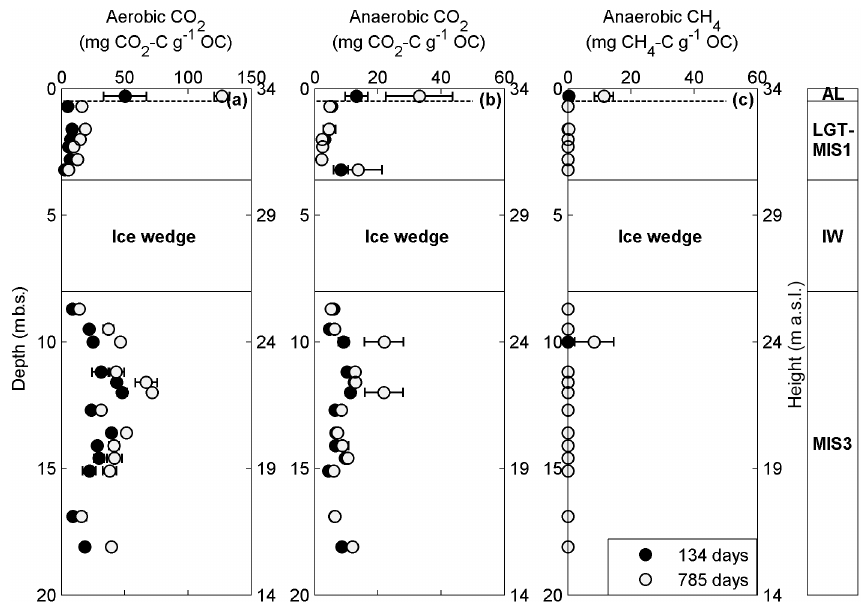
Figure 4. Depth profiles of total aerobic CO 2 (a) , anaerobic CO 2 (b) , and anaerobic CH 4 (c) production per gram of organic carbon (g − 1 OC) in sediment samples from the BK8 core after 134 (closed symbols) and 785 (open symbols) incubation days at 4 ◦ C for the active layer (AL), which is considered to be 0.5m thick, and permafrost deposits from the Holocene interglacial (MIS 1), including the late glacial transition (LGT) and the Kargin interstadial (MIS 3). Data are mean values ( n = 3) and error bars represent 1 standard deviation. Note the different